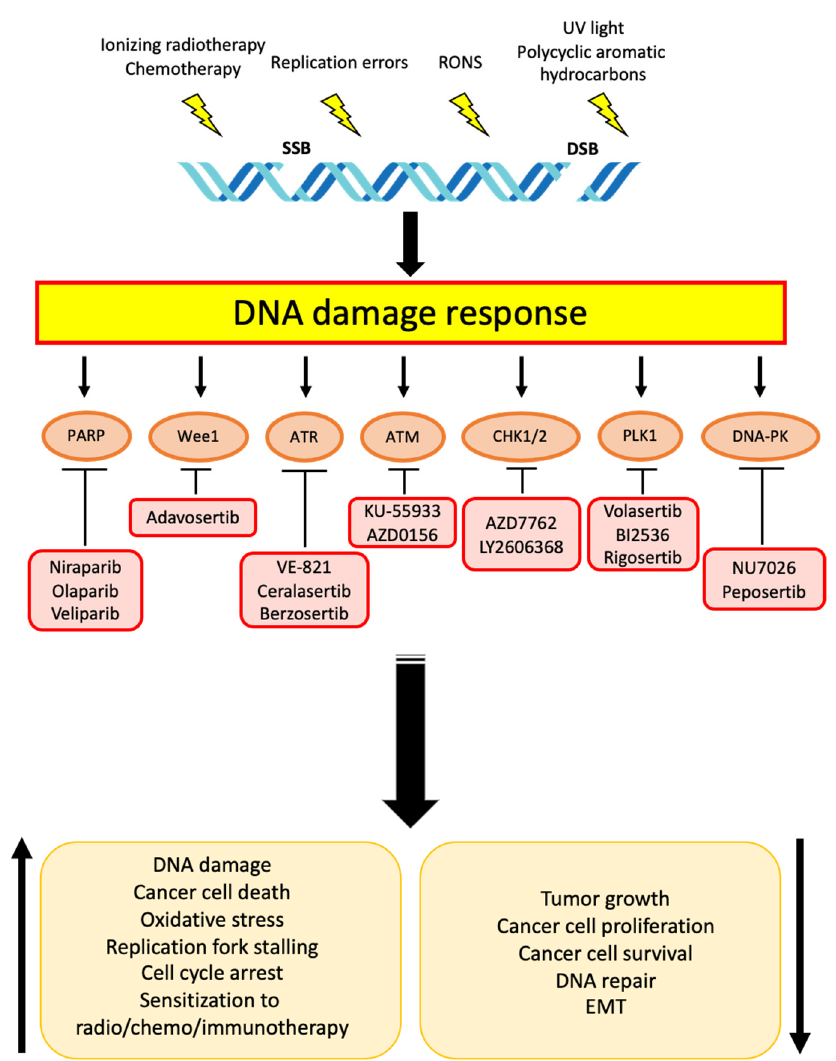
Figure 1. Schematic representation of DDR inhibitors used in preclinical and clinical studies for CCA therapy. Both exogenous and endogenous factors induce DNA damage (SSBs, DSBs). DNA ruptures activate DNA damage response (DDR) pathways. The main DDR proteins within their specific pharmacological inhibitors and the biological effects that have been observed in CCA cells are